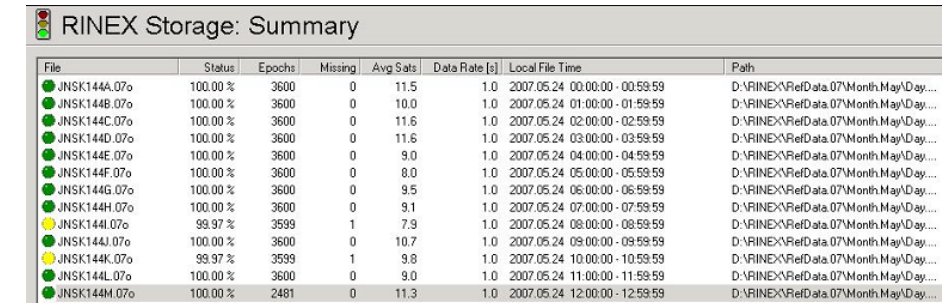
Fig. 9 . DGPSNet Processor window